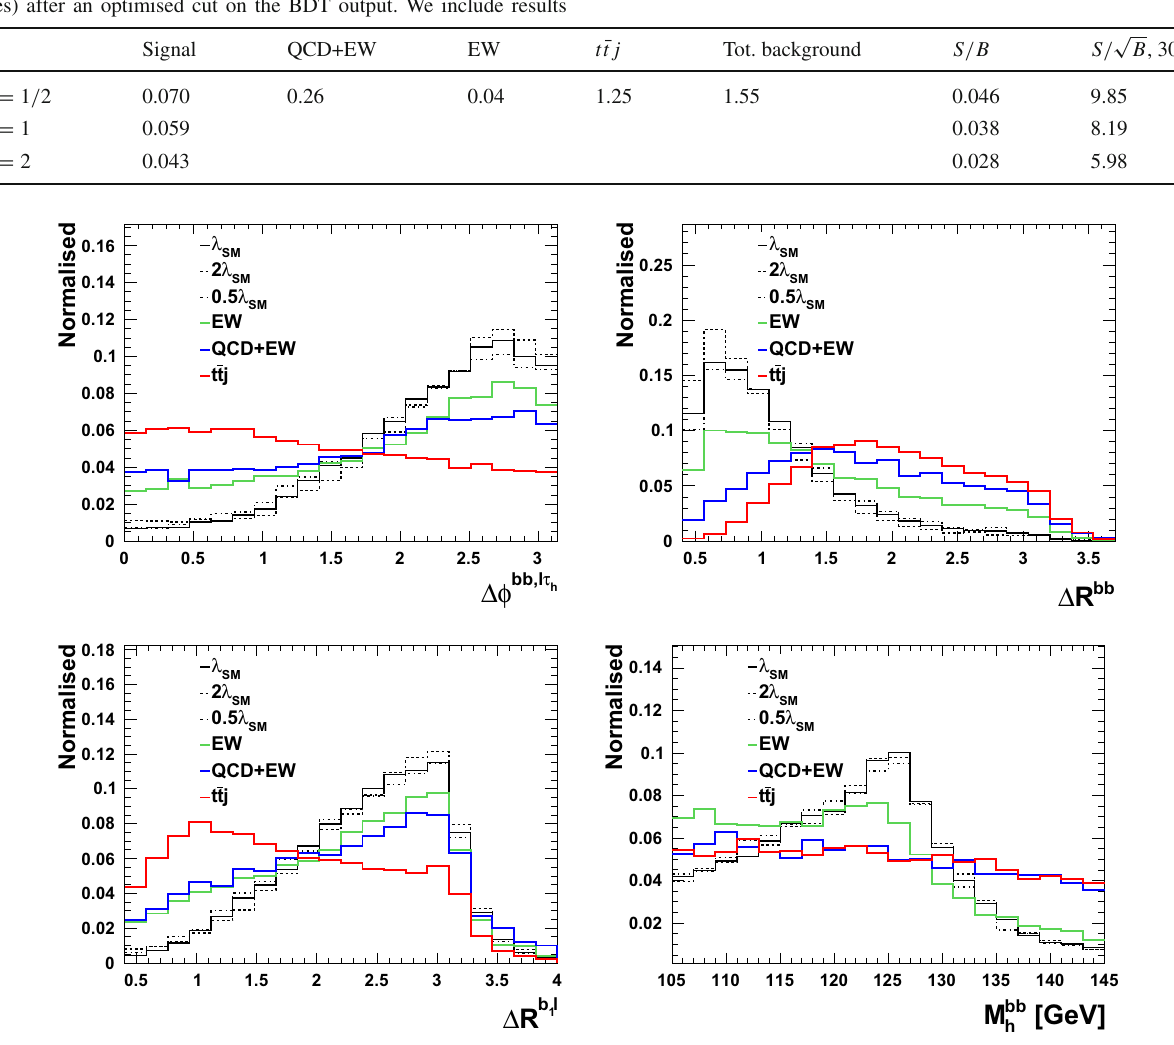
for three different choices of the self-coupling within the κ framework [64], κ λ = λ/λ SM ; BDT training is performed with λ = λ SM